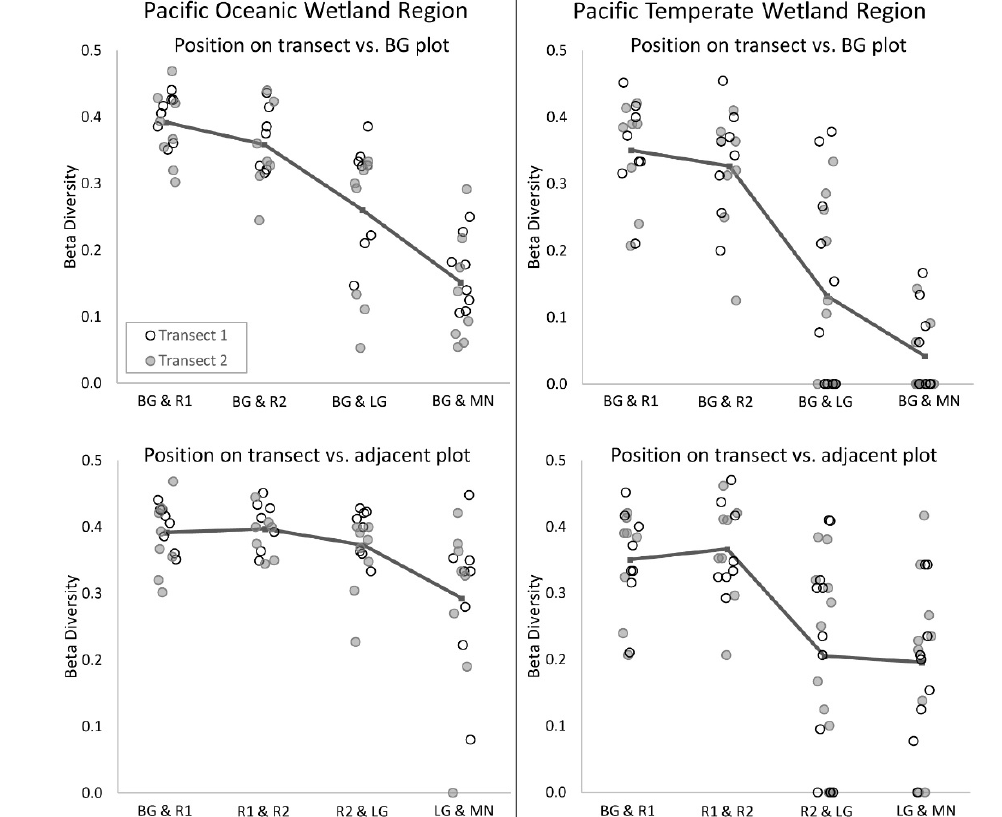
Figure 2. Sørensen Index of Beta Diversity comparing vegetation plots along the transects (R1, R2, LG, and MN) with the BG plot (upper row) and the adjacent plots on the transect (lower row). A value of zero indicates that paired plots had no species in common with each other. The symbols have been randomly offset along the x-axis for clarity. BG = bog, R1 and R2 = rand, LG = lagg, MN = minerotrophic ecosystem adjacent to lagg. Thick lines link mean values for the